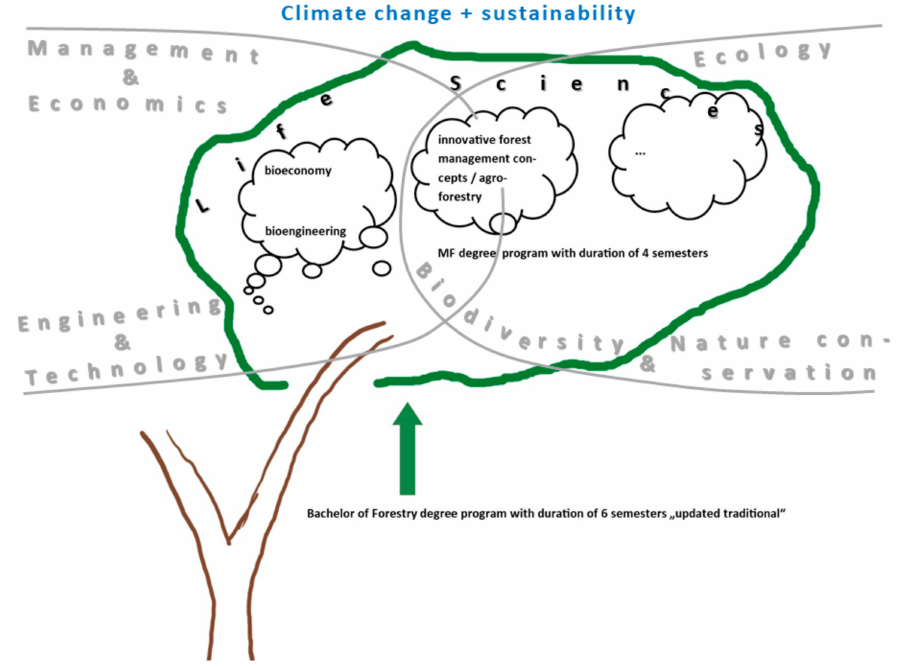
Figure 4. Concept of a consecutive graduation system of a six-semester bachelor’s study course and four-semester master’s study